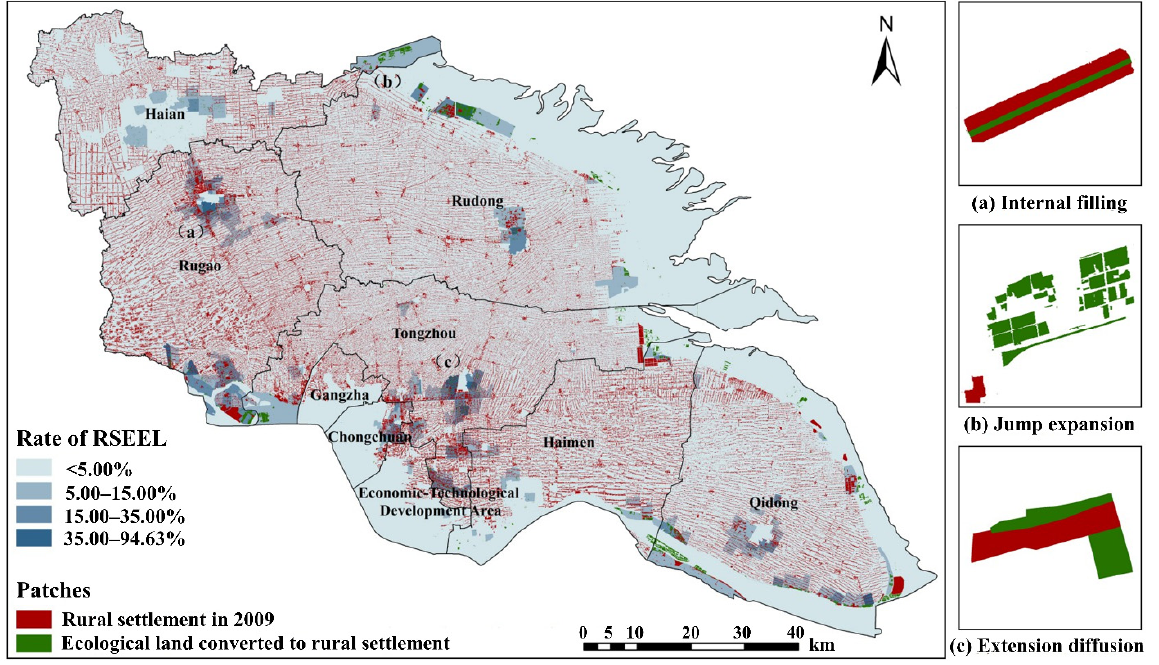
Figure 5. The pattern of RSEEL at the patch level and the rate of RSEEL at the village